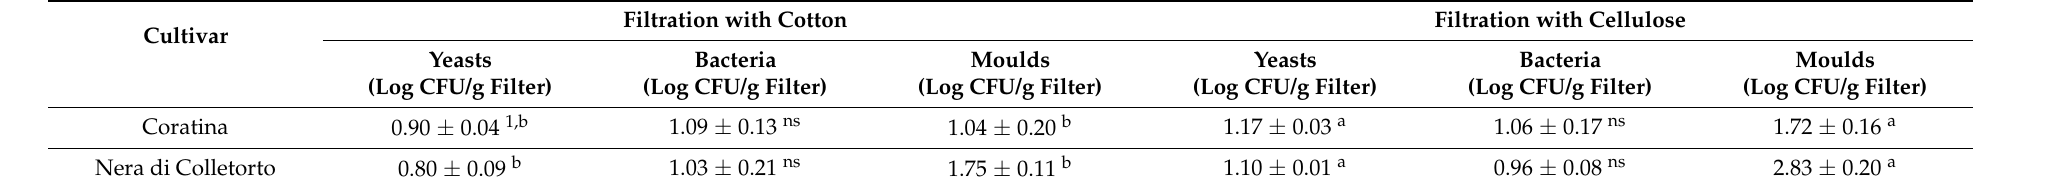
Table 4. Microbiological analysis of the cotton and cellulose filters used in the filtration of two monocultivar extra virgin olive oil. Cultivar